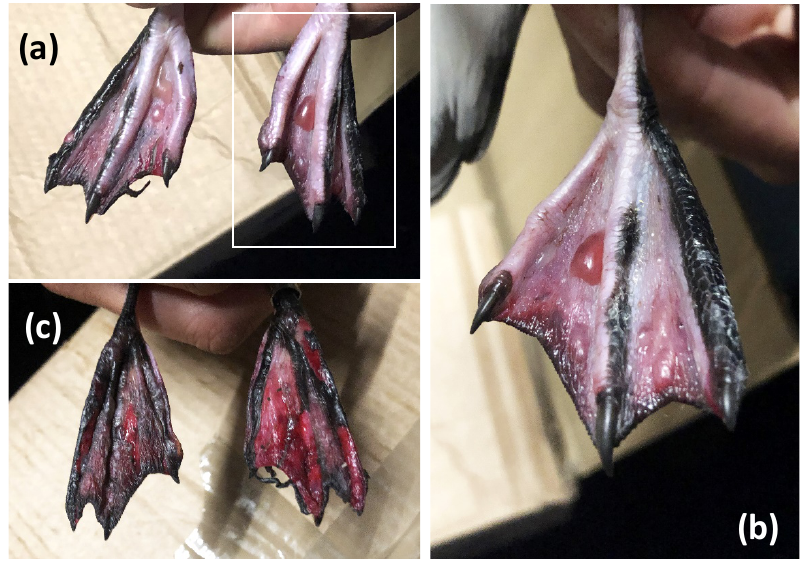
Figure 1. Blistering and necrosis of the foot web of a Manx Shearwater ( Puffinus puffinus ). ( a ) Dorsal surface of both feet showing epidermal blistering. ( b ) A close up of the blistering on the left foot as shown in the insert. ( c ) The ventral surface of both feet showing necrosis. Images © Paris Jaggers.